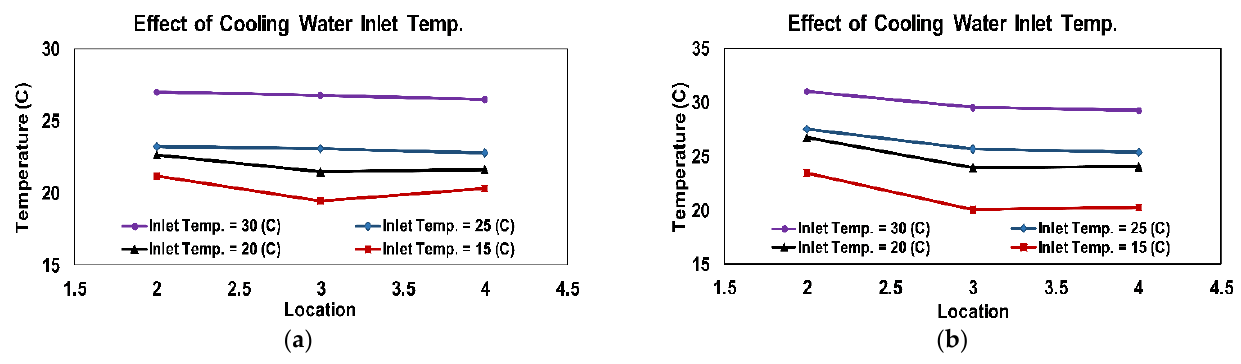
Figure 4. Effect of cooling water inlet temperature on the surface temperature of RMDHL, ( a ) input power 20 W, ( b ) input power 60 W.